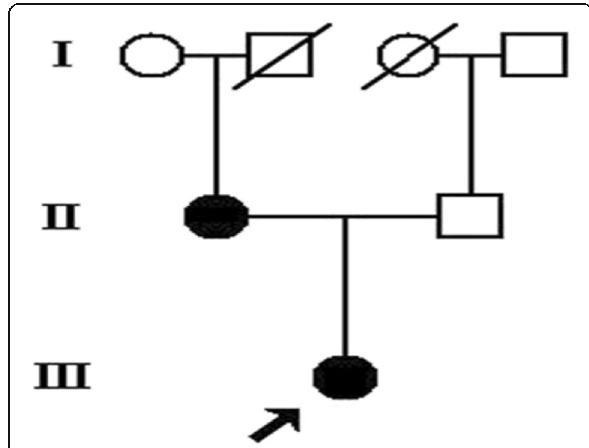
Fig. 1 Pedigree of the studied family; the proband is indicated by the